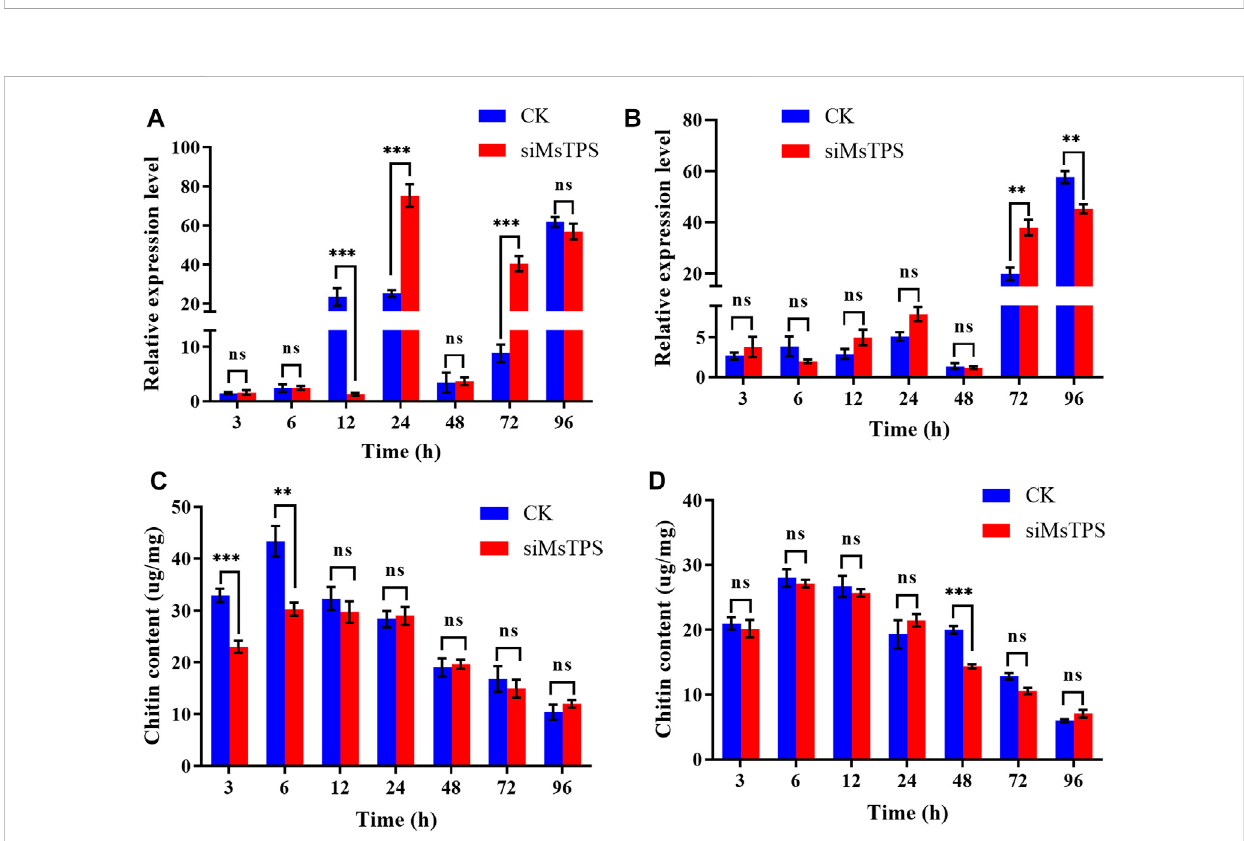
Effect of the silencing of MsTPS on chitin synthase gene expression and the chitin content. (A) Expression of MsCHSA at different time-points after the MsTPS RNAi treatment. (B) Expression of MsCHSB at different time-points after the MsTPS RNAi treatment. (C) Chitin content in the M. separata integument atdifferenttime-points after the MsTPS RNAitreatment. (D) Chitincontentinthe M.separata midgut atdifferenttime-points afterthe MsTPS RNAitreatment.Relative MsTPS expressionlevelsweredeterminedbyqRT-PCRandthe2 − ΔΔ CT dataanalysismethod.Expressiondataareprovidedas the mean ± SE. Data were normalized against the expression data for two reference genes (encoding β -actin and glyceraldehyde-3-phosphate dehydrogenase). Statistical analyses were performed using the GraphPad Prism software. Statistically signi fi cant differences by t -test at same treatment time shown as asterisks (* p < 0.05, ** p < 0.01, *** p < 0.001, ns >